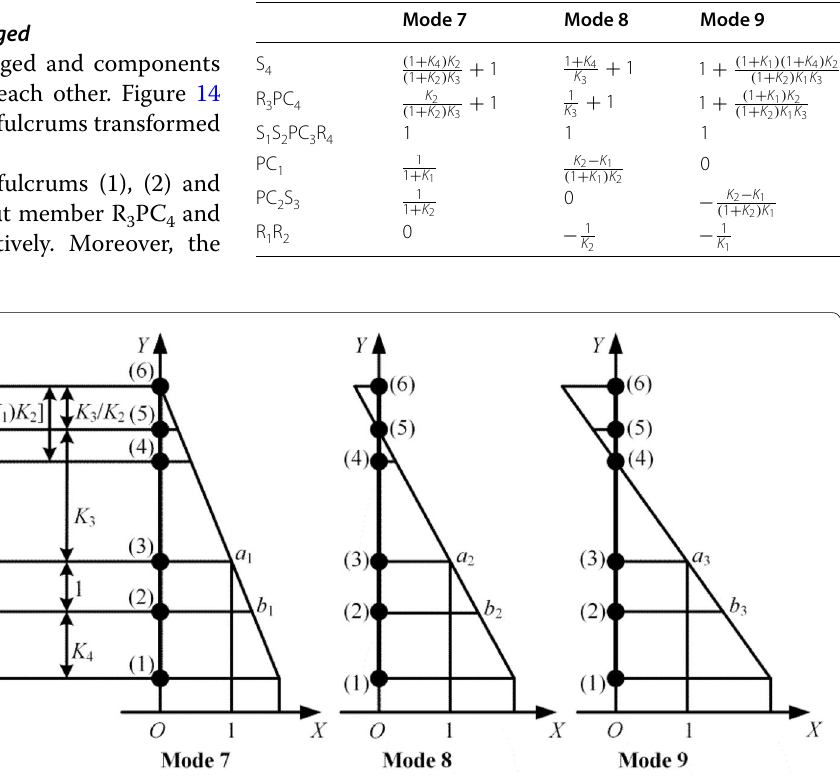
Figure 14 Equivalent lever speed diagram when clutch B engaged